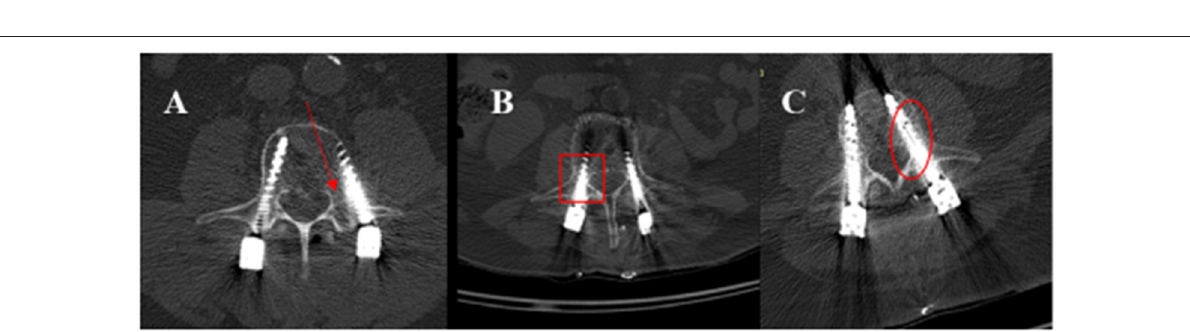
FIGURE 3 | Intraoperative 3D Rotation with C-arm. (A–C) the first scan bevor screws implantation ( A : sagittal, B : axial, C : coronar). (D) after screws implantation in coronar sequence.